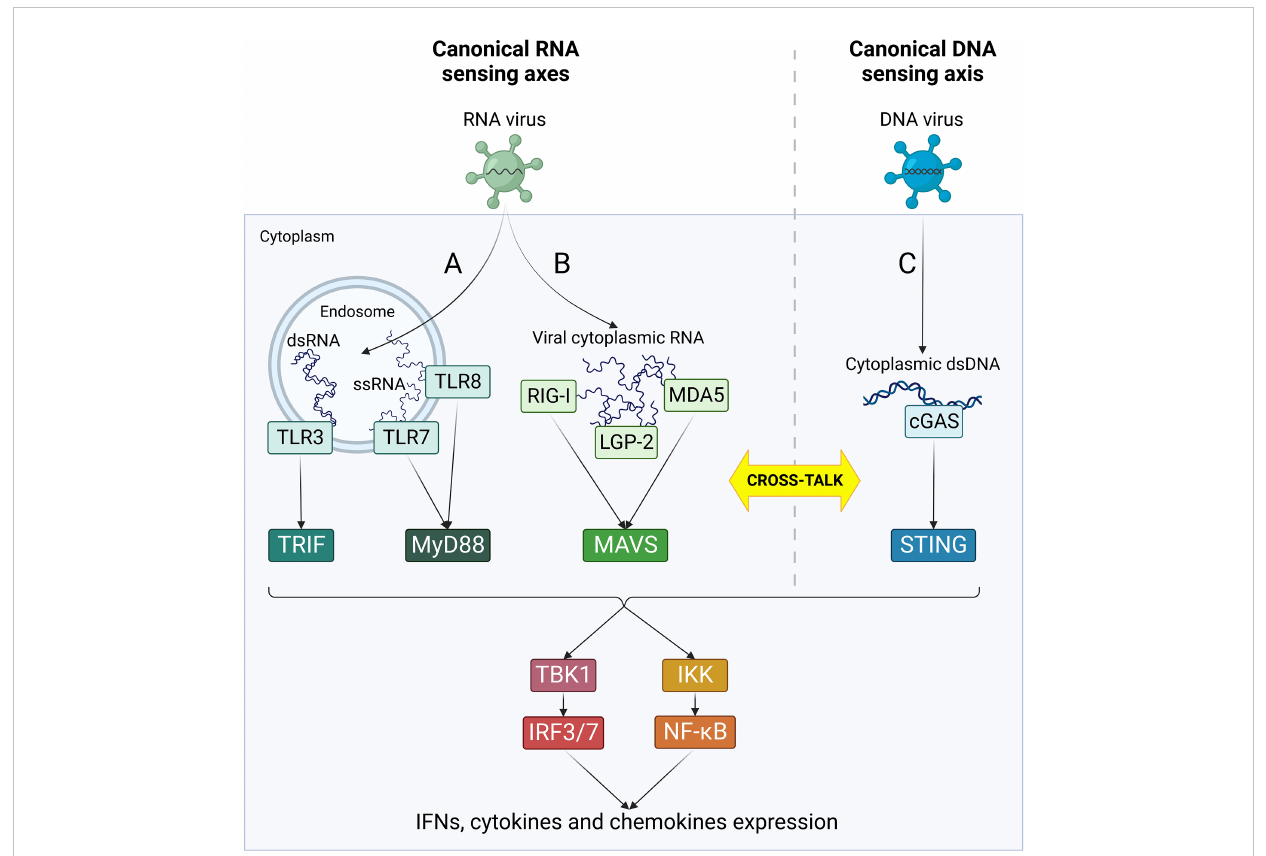
FIGURE 2 Canonical RNA- and DNA-sensing pathways. Following viral penetration into target cells, viral nucleic acids are recognized by cellular PRRs specialized in the detection of speci fi c RNA and DNA species. RNA-sensing pathways (in green) are mediated by TLRs (A) and RLRs (B) and can sense different types of virus-derived RNA in endosomes or cytoplasm, respectively. (C) cGAS/STING is the major cytoplasmic DNA-sensing axis (in blue) and it plays an essential role as primary player in the canonical response to DNA virus infections. According to each receptor activation, different adaptor molecules are recruited, leading to the formation of four separate innate immune axes: TRL3/TRIF, TLR7/8/MyD88, RLRs/MAVS and cGAS/ STING. Nonetheless, all these pathways converge in an unique cascade with the activation of TBK1/IRF3/7 and IKK/NF-kB, ultimately resulting in the activation of IFN response and cytokines production. Moreover, the four axes can cross-talk at different levels both directly and indirectly, leading to a complex network of interactions between the effectors of innate immune